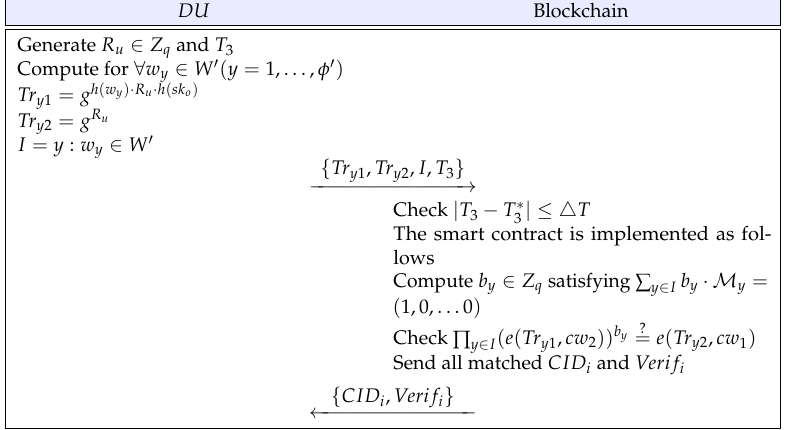
Figure 4. Data retrieval phase.